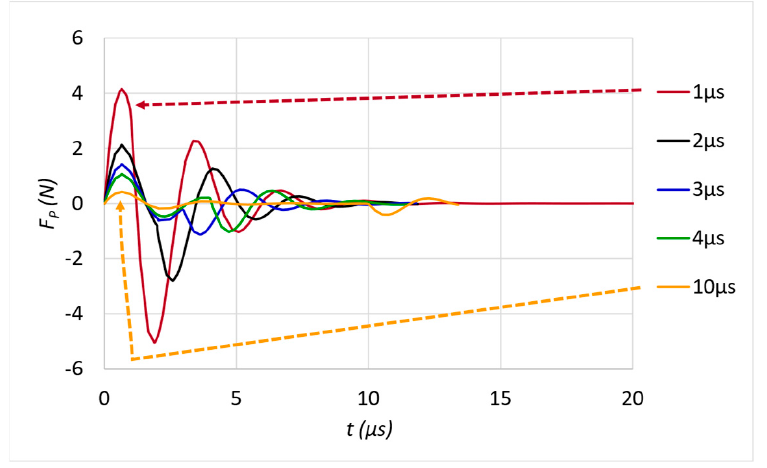
Figure 12. Estimated transient impact force, which is contributed by one multilayer actuator in the stator.